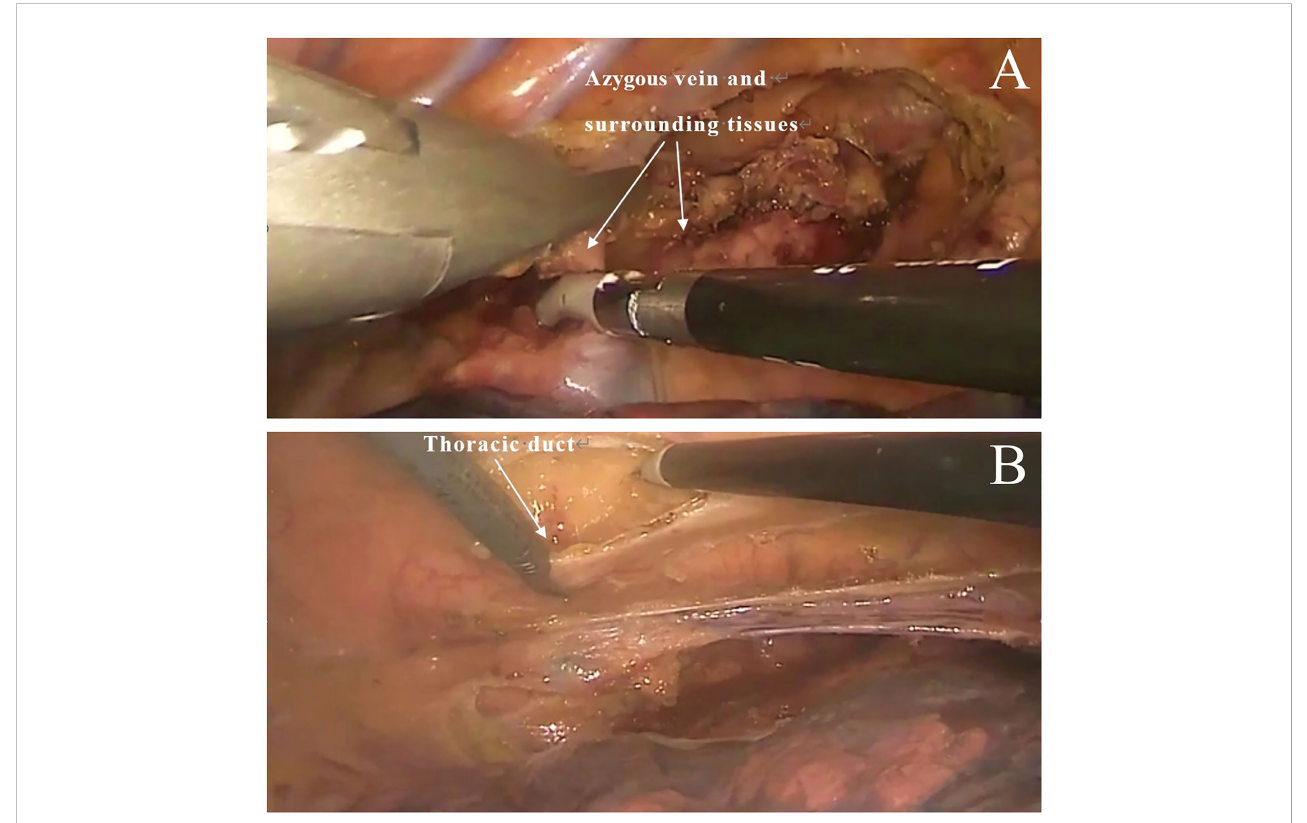
FIGURE 1 Traditional technique. (A) Excision of the azygous vein and surrounding tissues. (B) Excision of thoracic